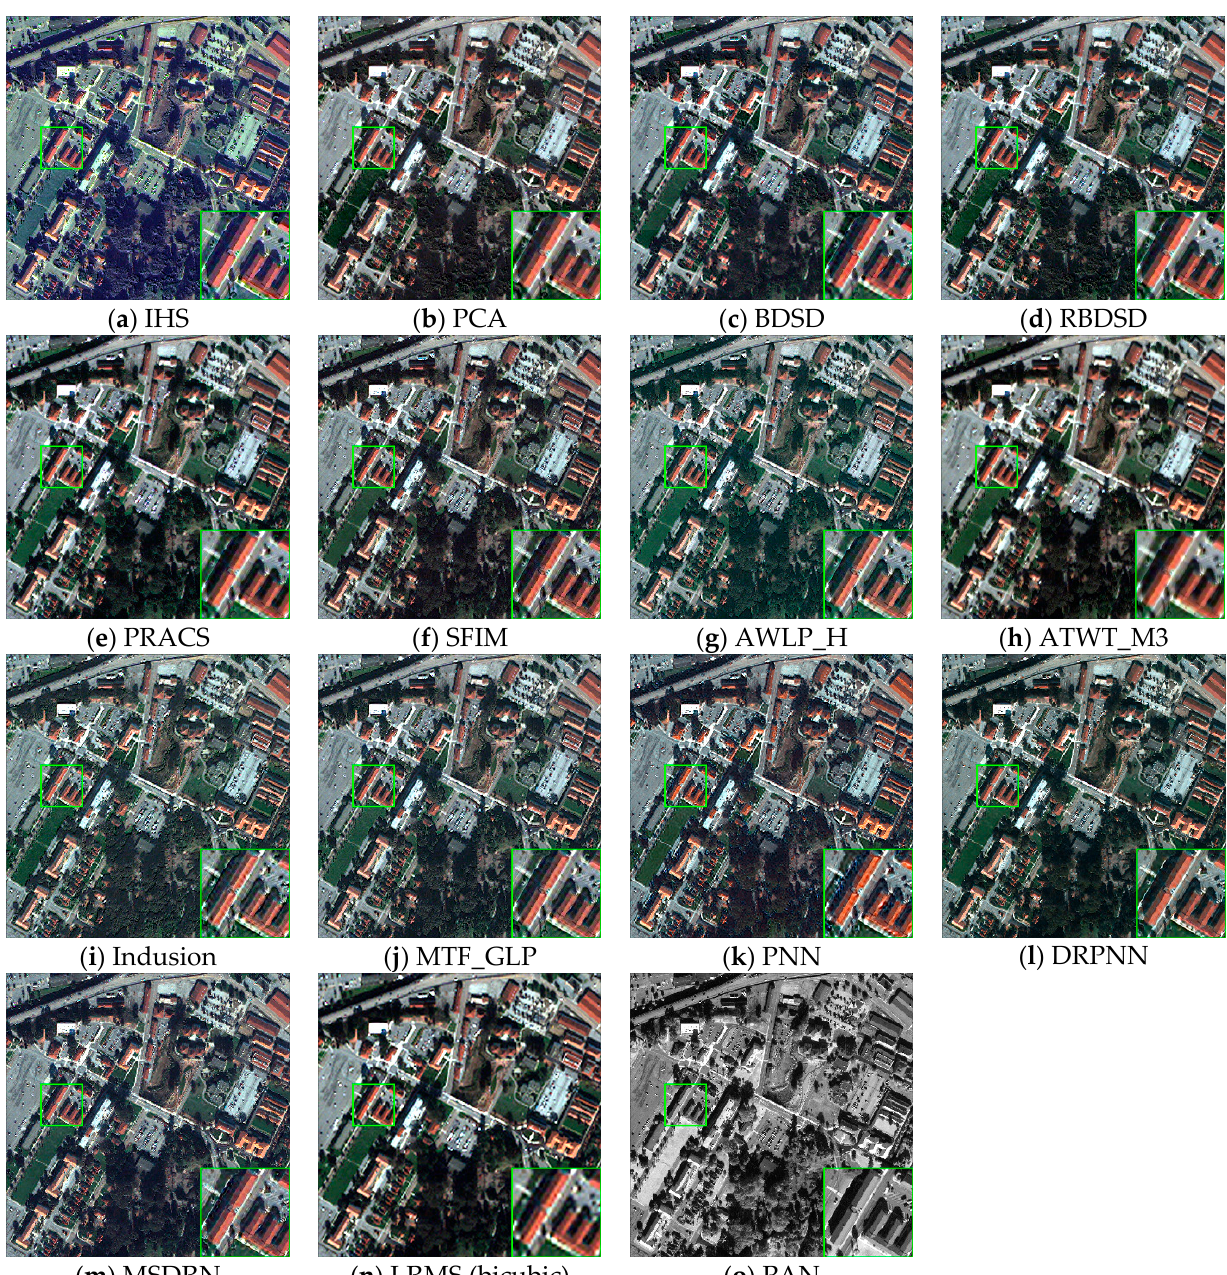
Figure 9. An example of real data experiments conducted on the QuickBird dataset. From ( a – o ) IHS, PCA, BDSD, RBDSD, PRACS, SFIM, AWLP_H, ATWT_M3, Indusion, MTF_GLP, PNN, DRPNN, MSDRN, LRMS (bicubic), PAN.